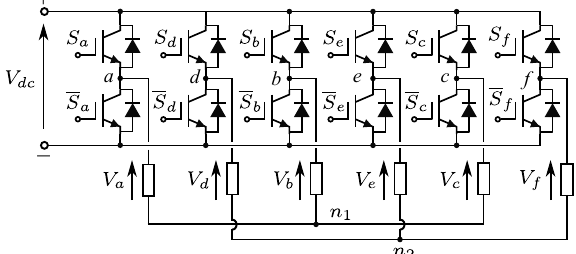
Figure 1. Six-phase voltage source converter (VSC) power-supplying a dual three-phase load with isolated